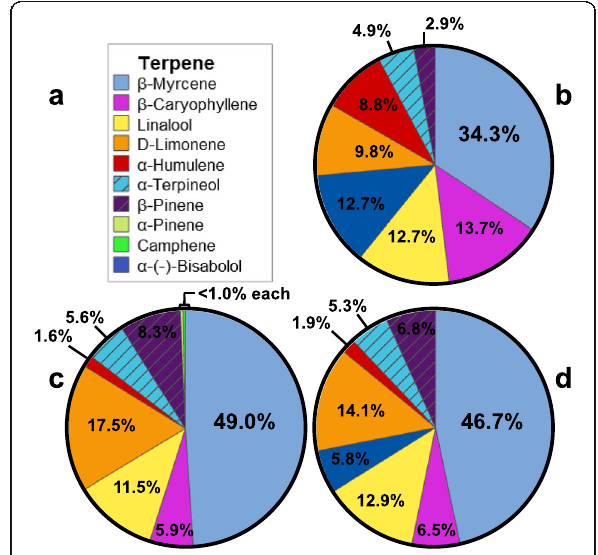
Fig. 1 a Terpene key, b terpene profile of the external terpene mixture, c aged one-year DjG inflorescence, and d aged one-month DjG inflorescence after 4 weeks in the presence of the mixture